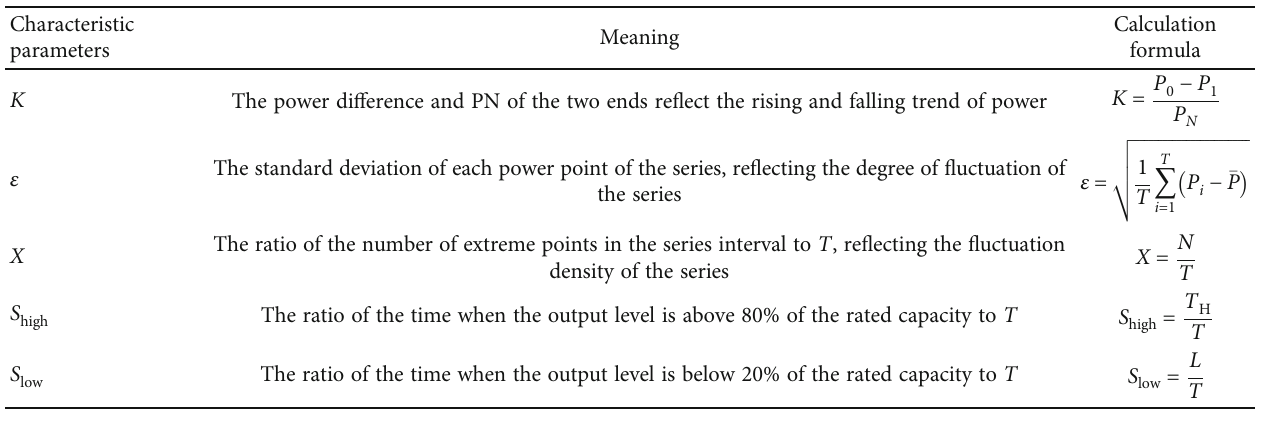
Table 1: Parameter classi fi cation.